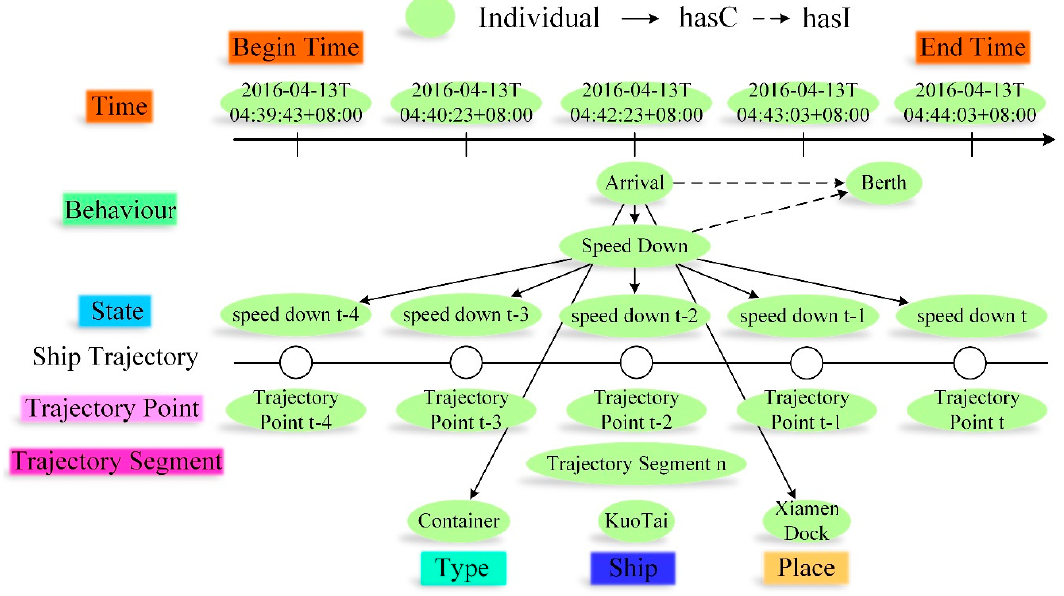
Figure 11. Running example: the Individuals after the Behavior reasoning when the ship arrives a a dock.